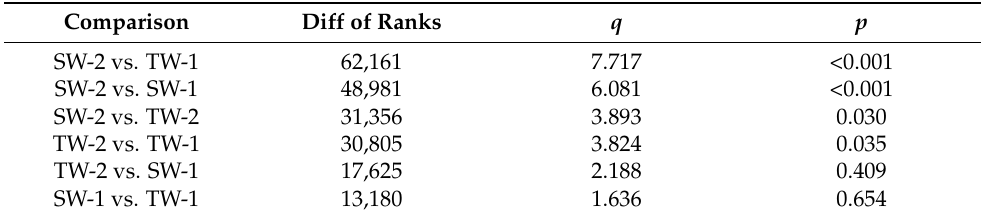
Table 4. Results of the Tukey test for each pairwise comparison of subsurface flow temperature ( ◦ C) levels for the wells in the stream (SW-1 and SW-2) and intermittent tributary (TW-1 and TW-2) from 1